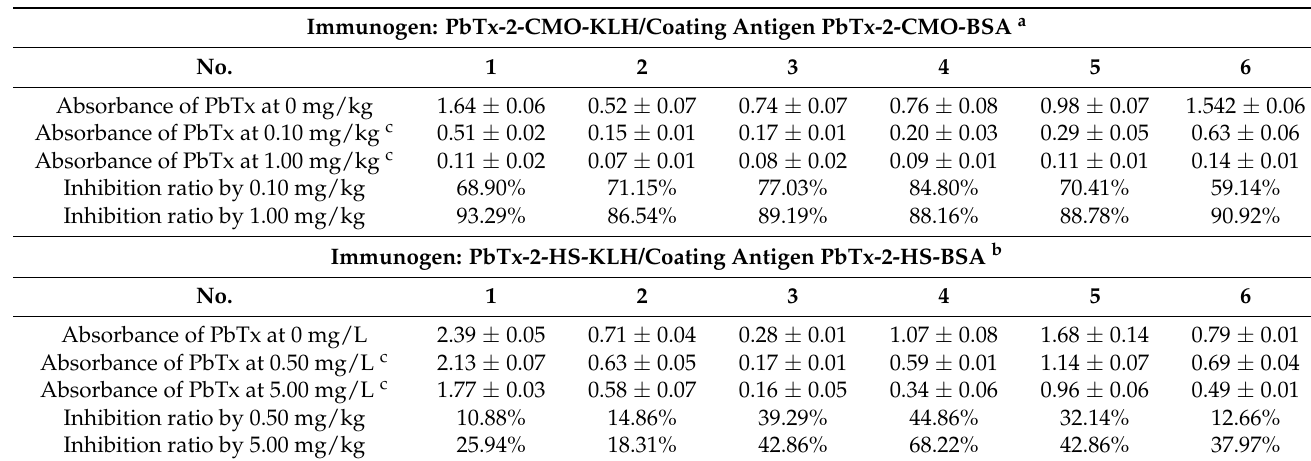
Table 1. Immunization with PbTx-2-CMO-KLH and PbTx-2-HS-KLH.